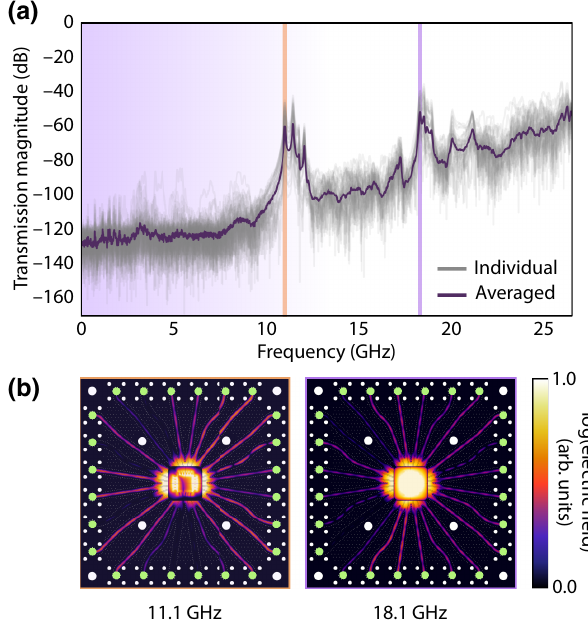
FIG. 4. Package mode measurements and simulation. (a) Package modes are probed at liquid nitrogen temperature using a multiport vector network analyzer. The scattering matrix ele- ments corresponding to transmission across the package cavity, as measured via the ports marked green in (b), are overlaid (gray) and averaged (dark purple). (b) EM simulations reveal eigenmodes at 11.1 GHz (orange) and 18.1 GHz (purple), which correspond well with the measured peaks as marked by the cor- respondingly colored vertical lines in (a). The purple background fading out with increasing frequency in (a) indicates the decreas- ing relevance of modes as their frequency separation to the qubit transition frequency